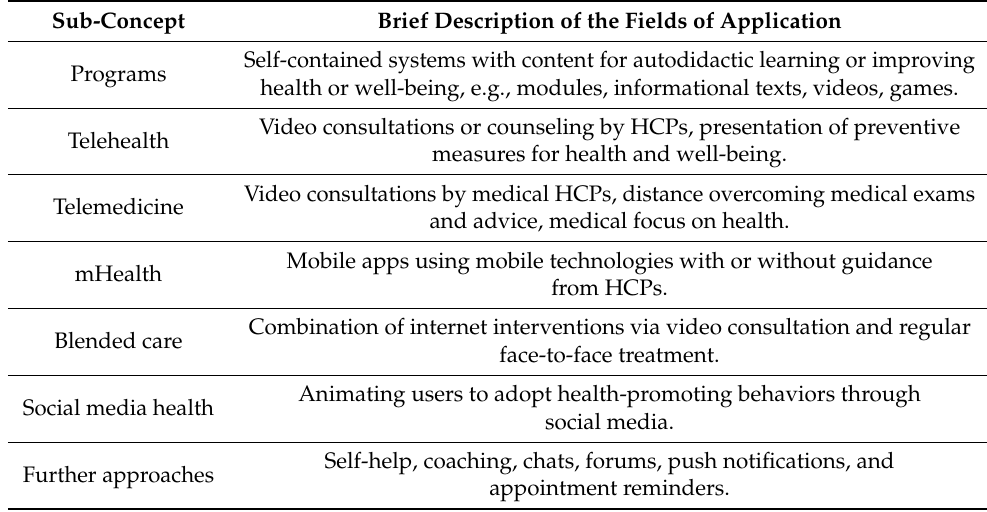
Table 1. E-health sub-concepts and their fields of